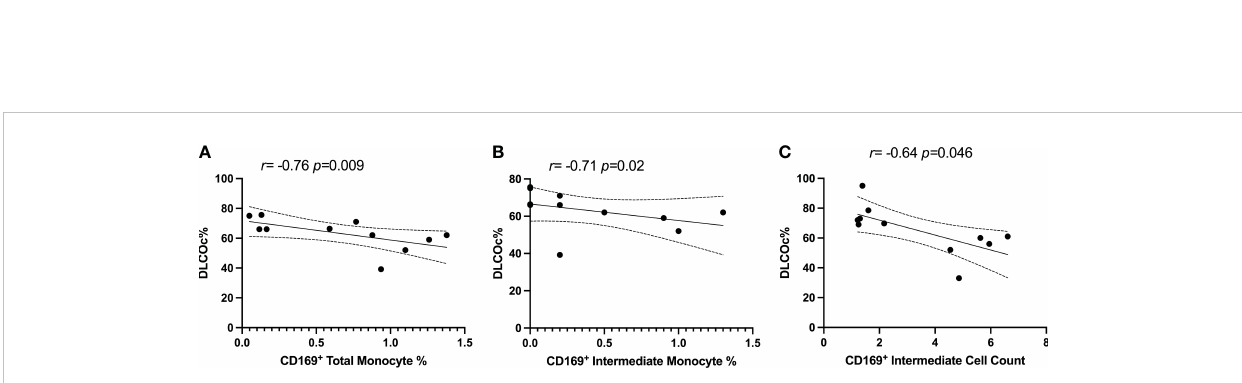
FIGURE 5 Spearman correlation between DLCOc% and (A) percentage of CD169 + total monocytes, (B) percentage of CD169 + intermediate monocytes, and (C) CD169 + intermediate monocyte count in